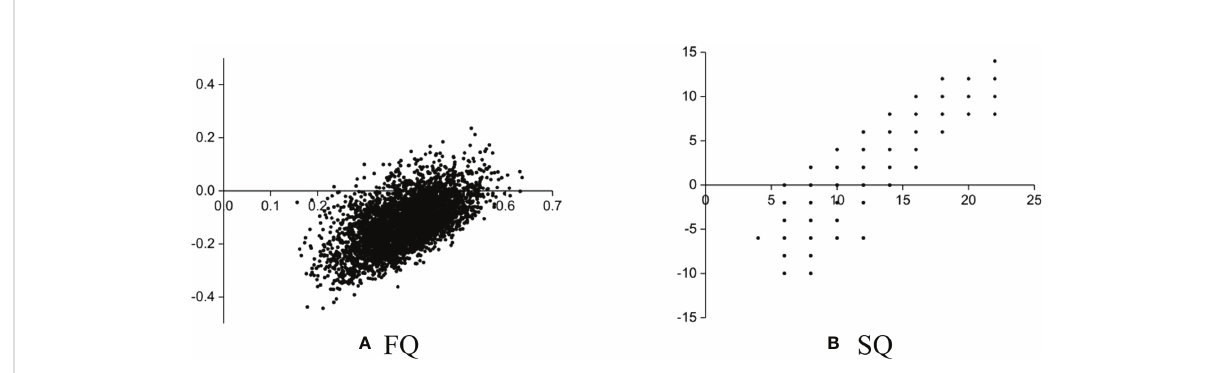
FIGURE 8 Errors between estimated and measured FQ and SQ. (A) FQ (B) SQ.